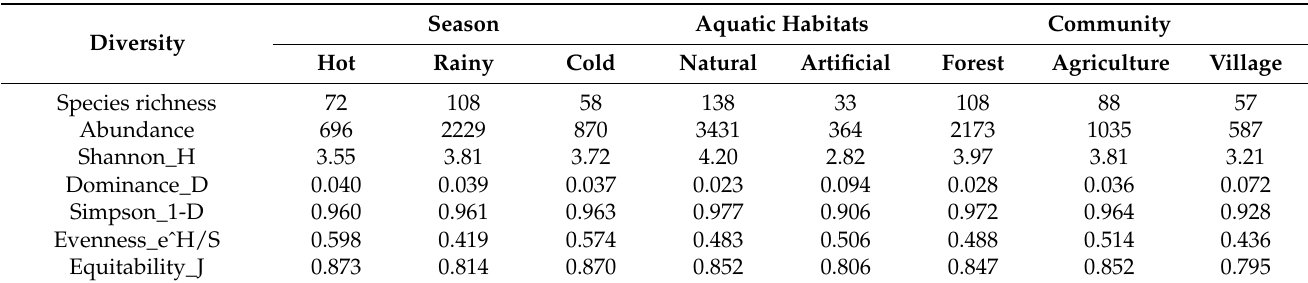
Figure 7. Mosquito species richness accumulation curves showing seasonal richness comparisons. The shaded area on either side of the lines represents 95% confidence intervals. Solid line = interpo- lated; dash line = extrapolated. Estimated sample coverage of the reference sample for each season: rainy = 0.9928, cold = 0.9908, and hot = 0.9943. q = 0, species richness with bootstrap of 1000. Table 1. Diversity of mosquitoes in Doi Inthanon National Park.